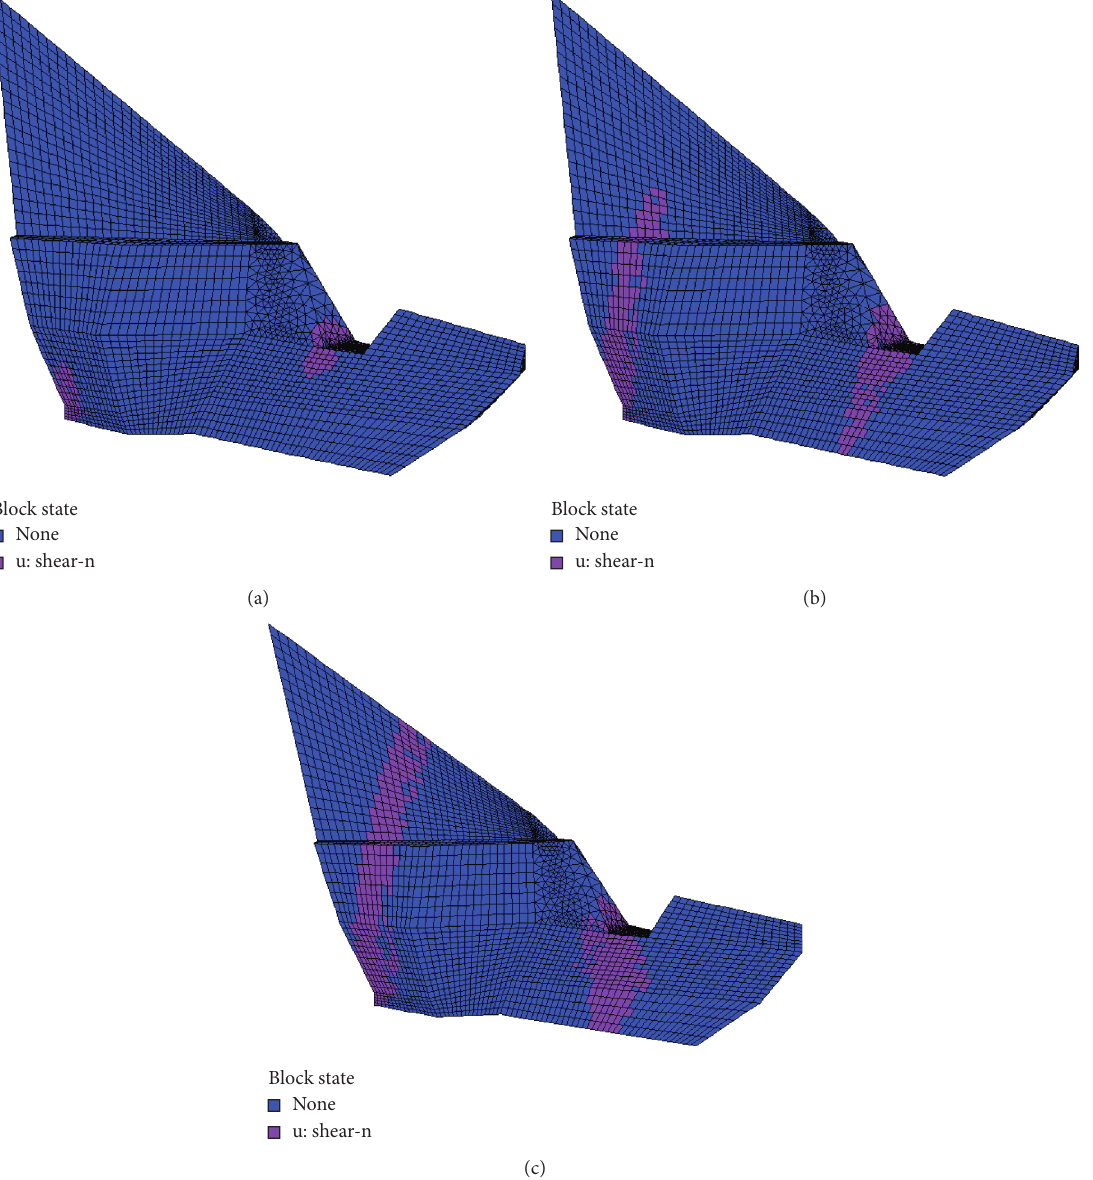
Figure 15: Evolution of the plastic zone of the potential failure region with the SRF, (a) SRF � 1.10, (b) SRF � 1.26, (c) SRF �